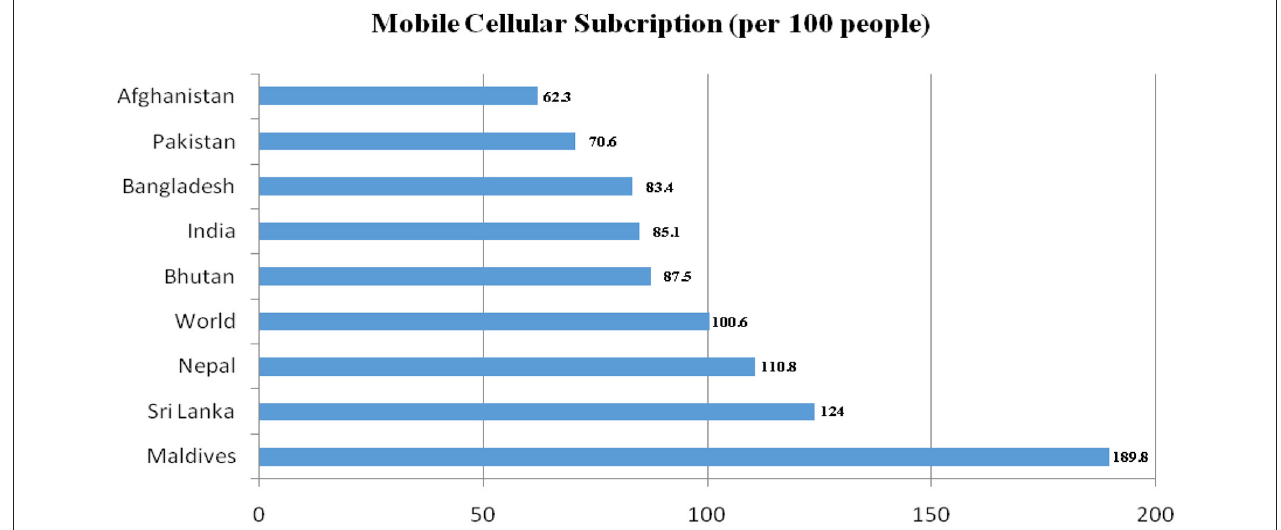
FIGURE 1 | Mobile Cellular Subscriptions in South Asia in 2016. Data used under CC BY-4.0 www.creativecommons.org/licenses/by/4.0 (29).